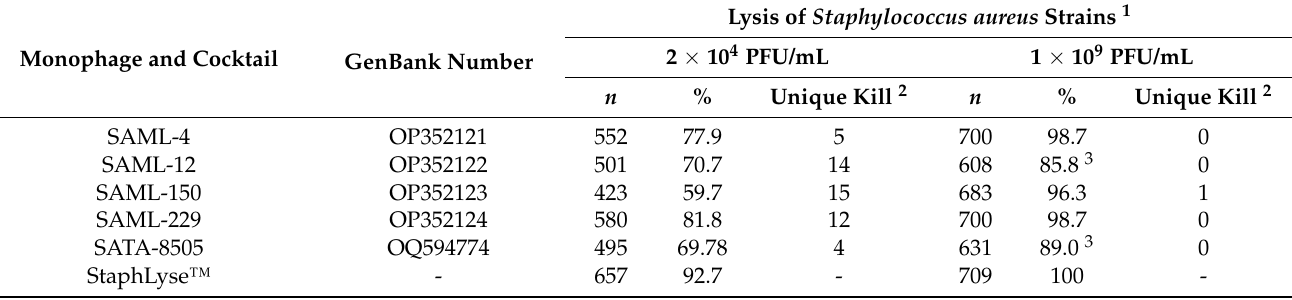
Table 1. Lytic spectrum of individual S. aureus monophages and cumulative lytic spectrum of the StaphLyse™ phage cocktail at two concentrations.